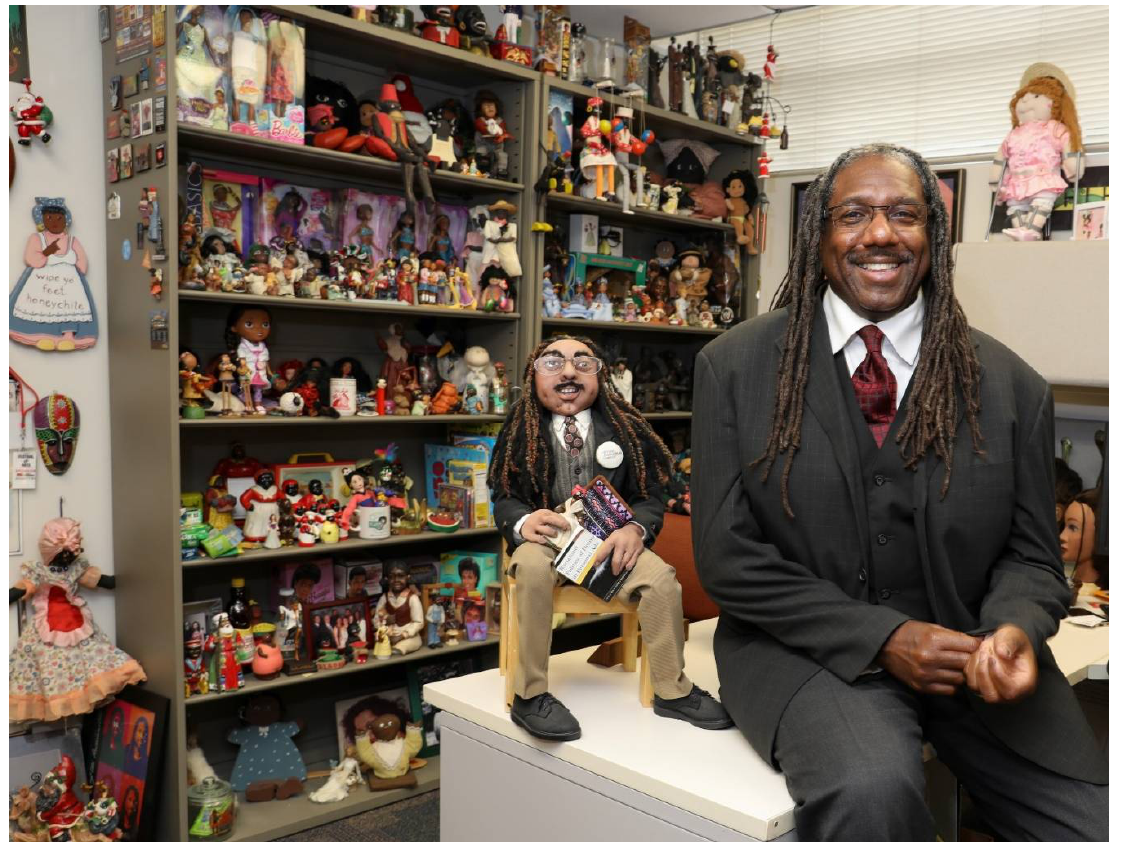
Figure 4. Pictured in 2017 in my office with a custom-made Mimi-me doll by artist Rebecca Ragan Akins on the occasion of my service as chair the board of directors of our State Humanities Council. Photo Credit: Ahwatukee Foothills News .